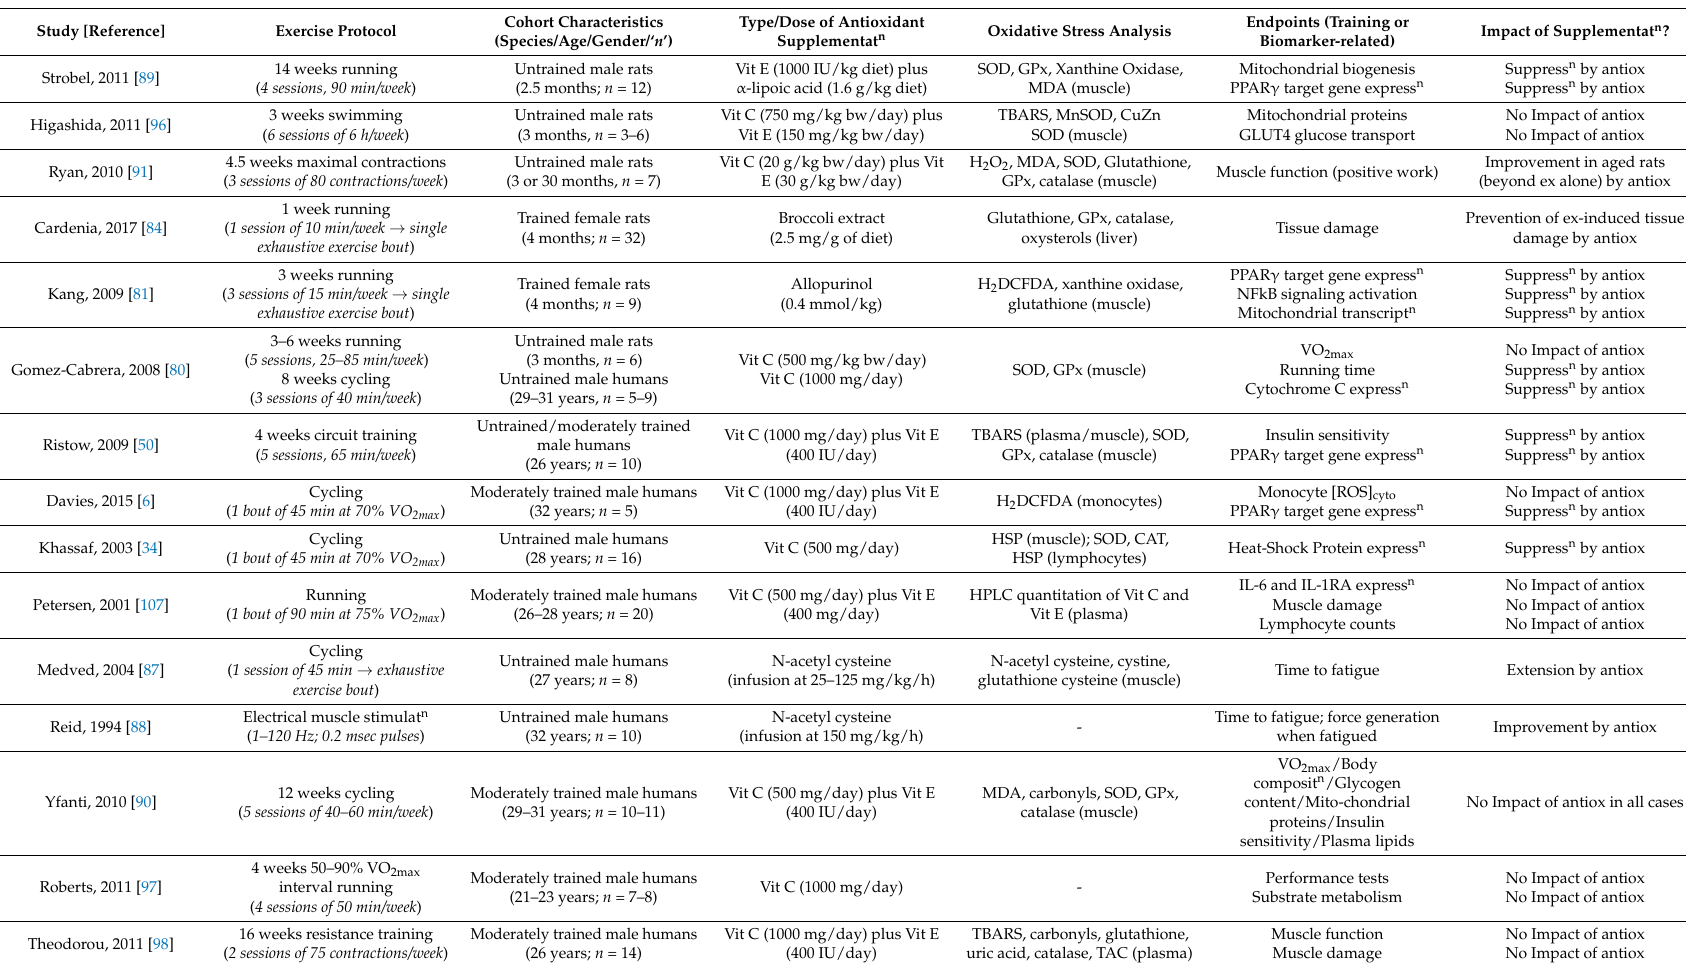
Table 1. Summary of findings of previous studies regarding the impact of dietary antioxidant supplementation on exercise training or biomarker